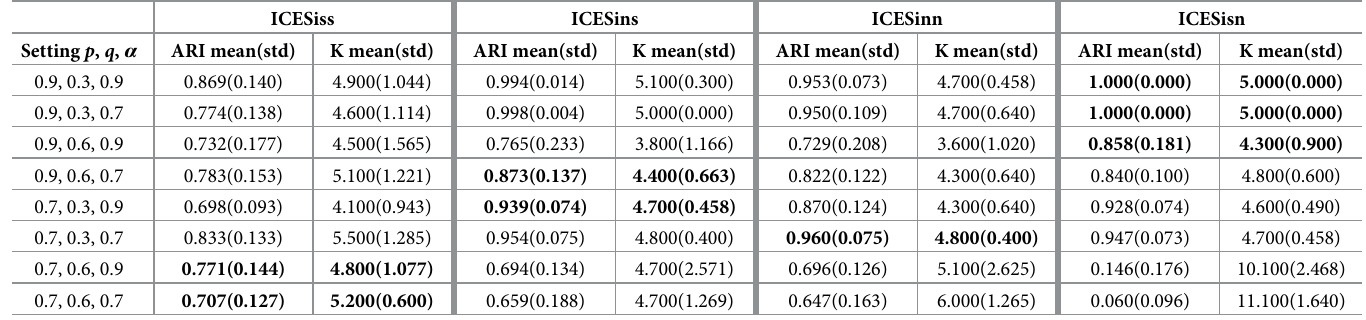
Table 13. The performance of ICESi methods at small-size networks with quantitative features at the nodes; with selected data pre-processing for each algorithm: The average ARI index and its standard deviation over 10 different data sets. ICESiss ICESins ICESinn ICESisn Setting p , q , α